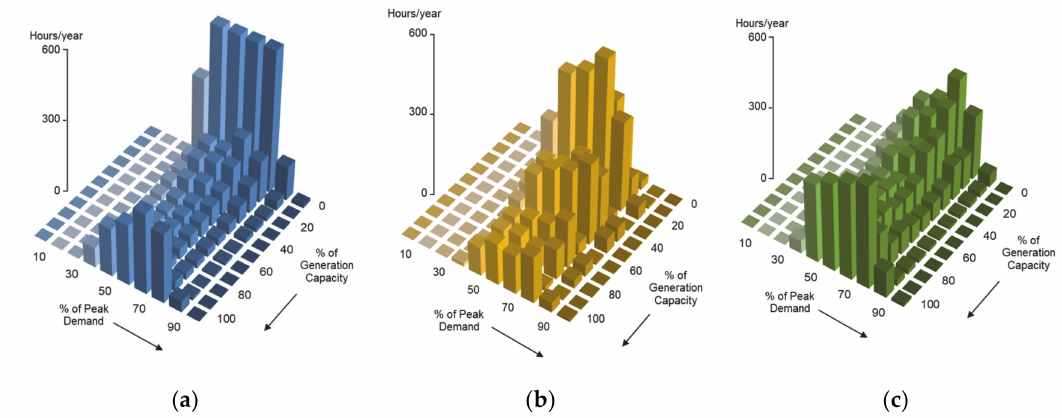
Figure 5. Coincident hours of load and generation states for each o ff shore renewable. Bins are centred at 10% steps of the peak value of each profile: ( a ) tidal and demand; ( b ) wave and demand and ( c ) wind and demand. Table 4. Annual duration of worst case scenarios expected to limit the connected capacity for each configuration of generation topology. The level of demand (d), and tidal (t), wave (wv) or wind (wn) generation is indicated as a percentage of its maximum, for example, d04t10 signifies a period with demand at 40% of peak and tidal at 100%.